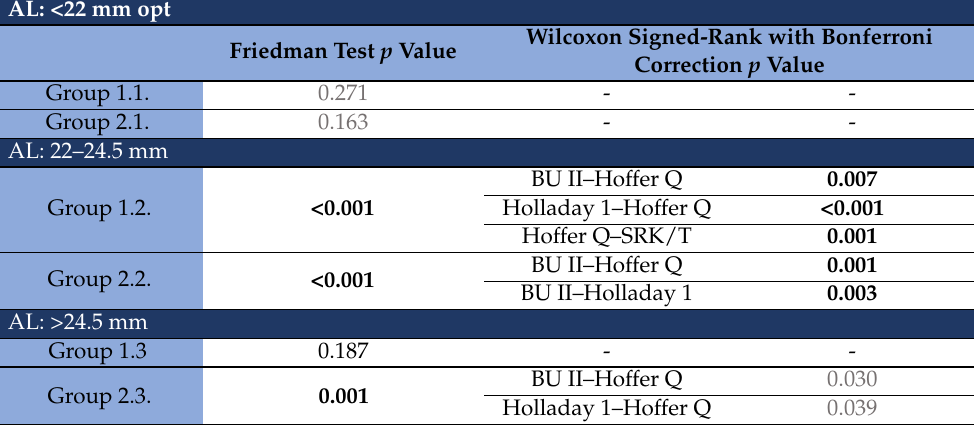
Table 6. p values obtained by the statistical analysis comparing the optimized formulas in each